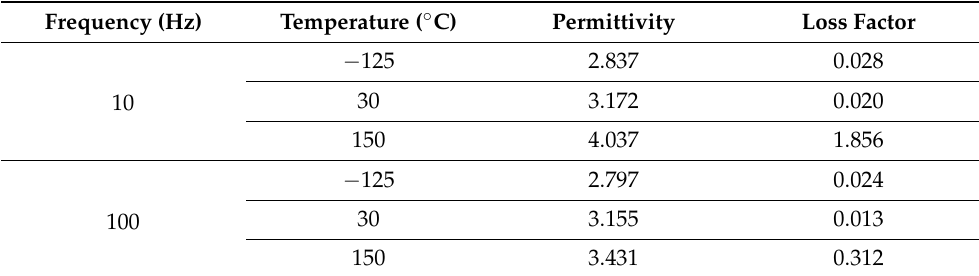
Table 7. Permittivity and loss factor of cured resin at 10, 100, 1000 and 10,000 Hz, and − 150, 30 and 150 ◦ C at DGEBA:B10 =